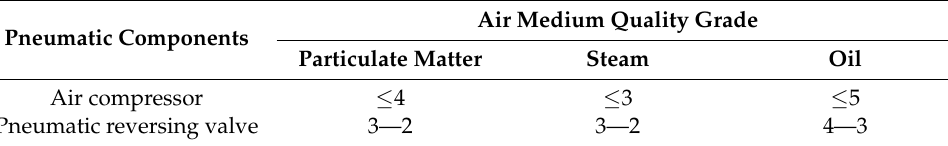
Table 1. Air media quality class for pneumatic components and